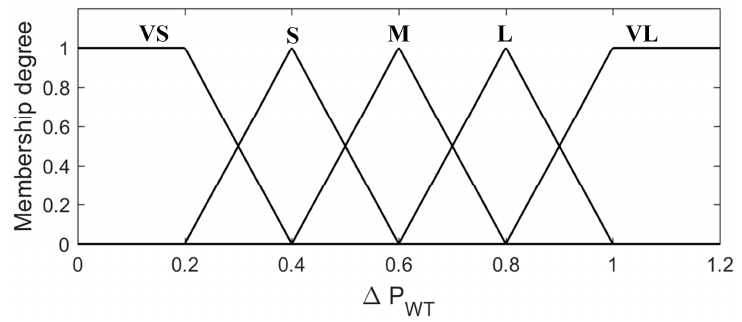
Figure 4. Membership function (power reserve).